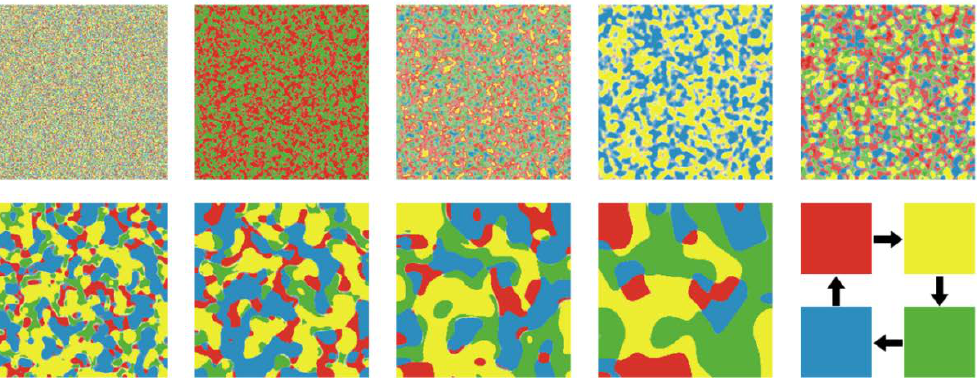
Figure 9. Cellular automaton of the culture-scale FSM within a square world with closed borders starting from random values for all the regulatory proteins with ∆ t = 0.001 and D R = 0.01 for all species. Nine different time steps of a base-case simulation are shown before the system reaches full synchronization (time sequence from left to right).